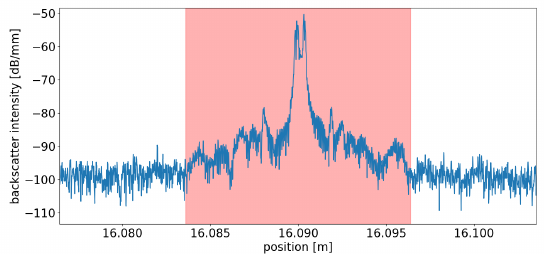
Figure 3. Detailed view of single scattering center. The shaded area depicts the (virtual) integration width from which the scatterer’s integral power is